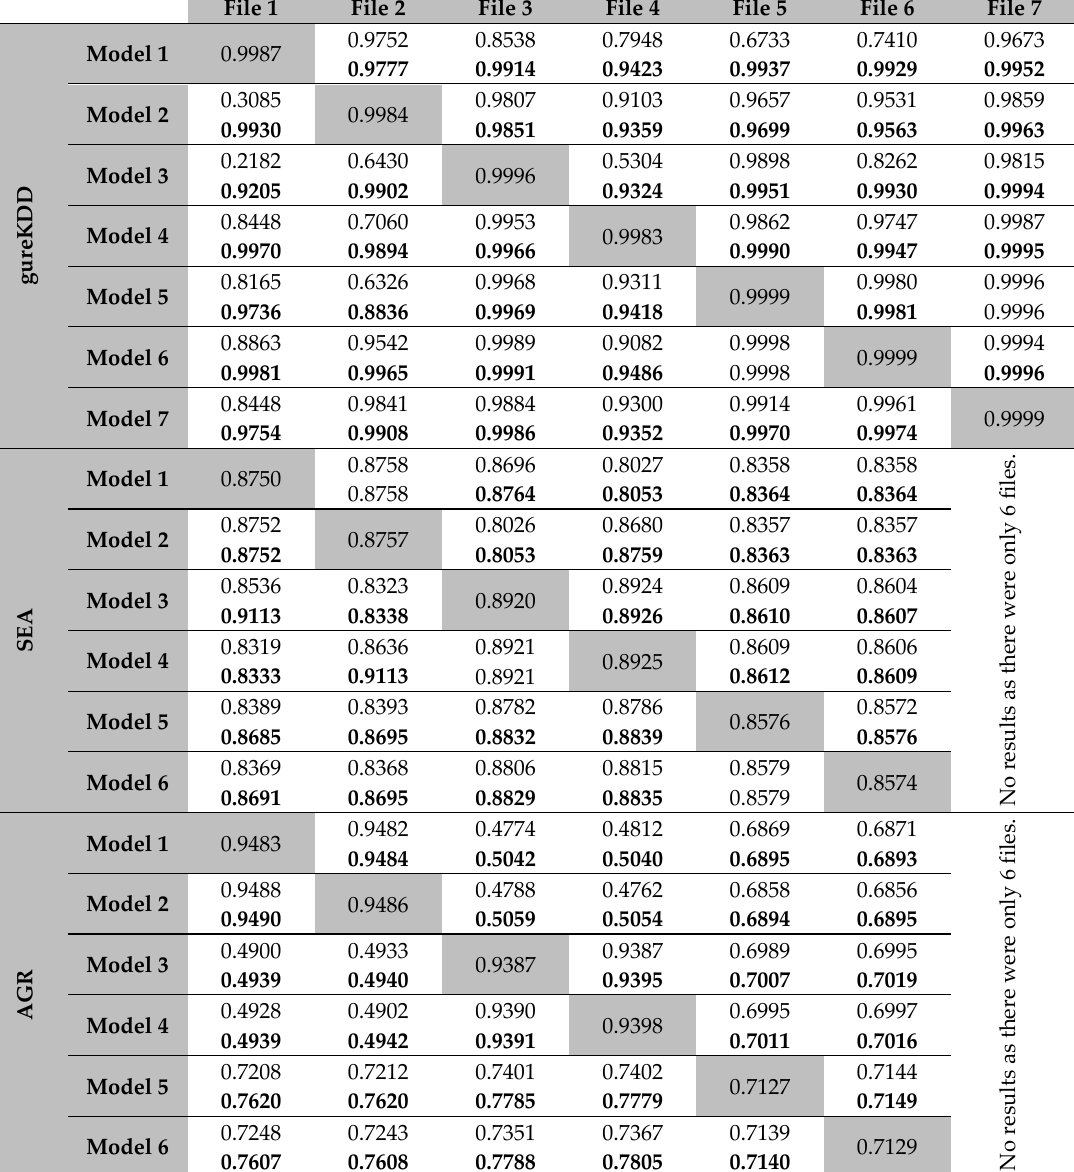
Table A2. Random Forest (RF) model’s performance on di ff erent datasets with various e ff ects (before Table 2. Random Forest (RF) model’s performance on different datasets with various effects (before and after threshold adaptation). and after threshold